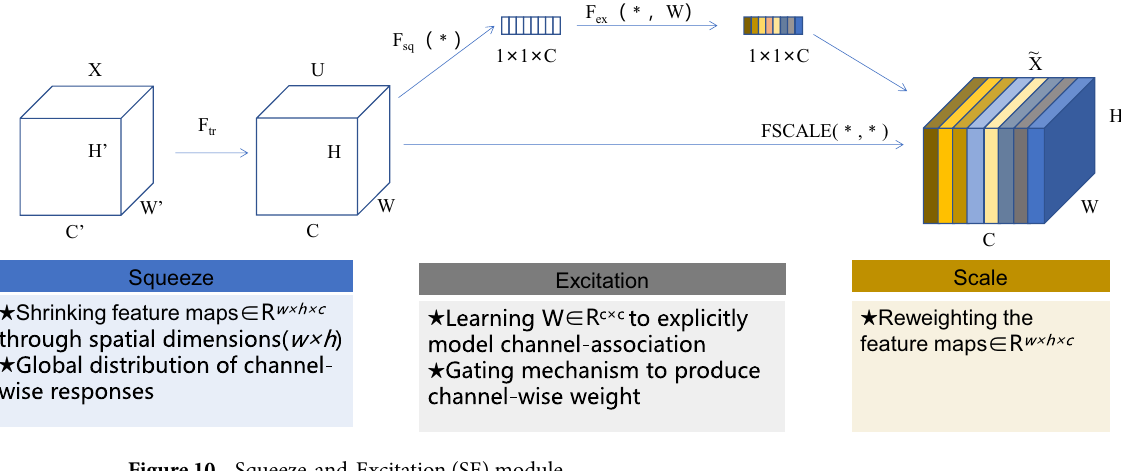
Figure 10. Squeeze-and-Excitation (SE)